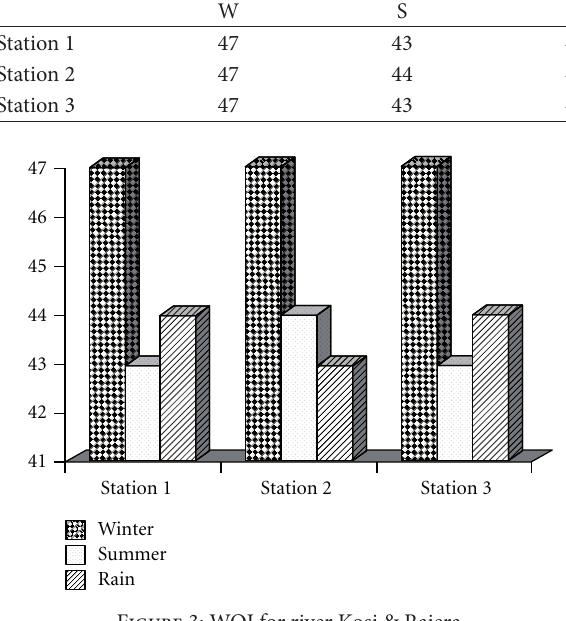
F 3: WQI for river Kosi &